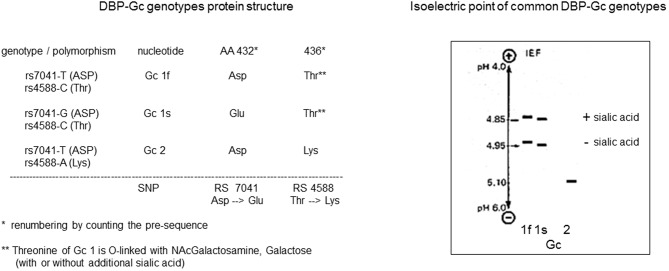
DBP/GC polymorphism as revealed by measurement of their isoelectric point and protein structure.